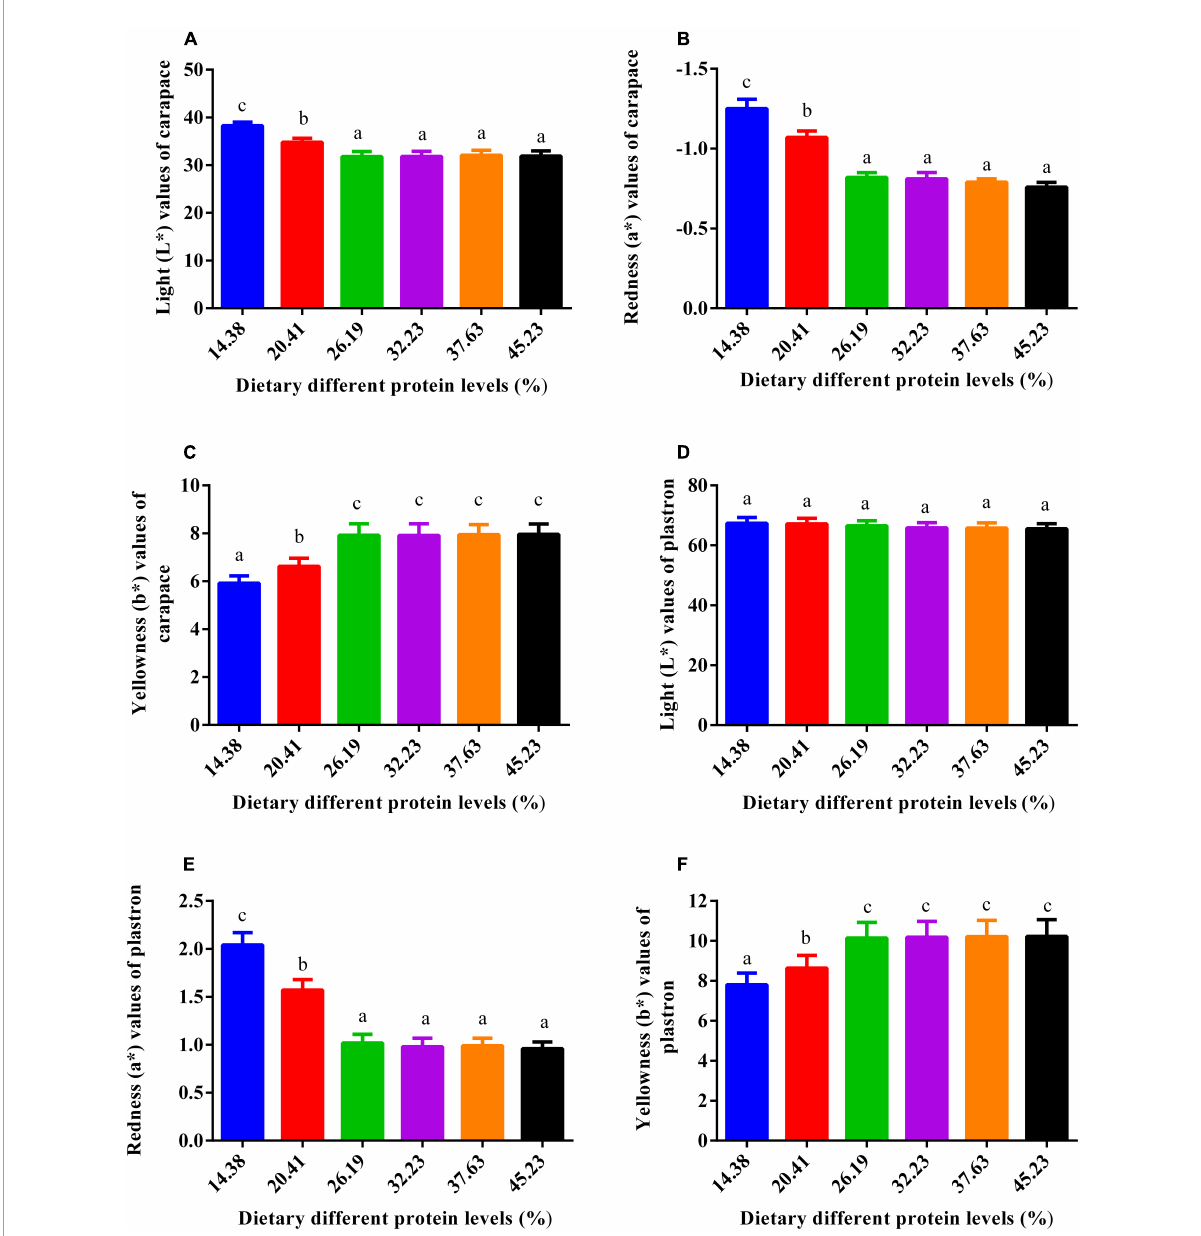
FIGURE4 Impact of dietary gradient protein levels on the skin color of juvenile softshell turtles after 8 weeks of feeding. (A) Lightness (L*) values in the carapace; (B) redness (a*) values in the carapace; (C) yellowness (b*) values in the carapace; (D) lightness (L*) values in the plastron; (E) redness (a*) values in the plastron; (F) yellowness (b*) values in the plastron. Bars with different letters indicate significant differences among the groups ( P < 0.05). The values shown are the mean ± SD for three replicates.